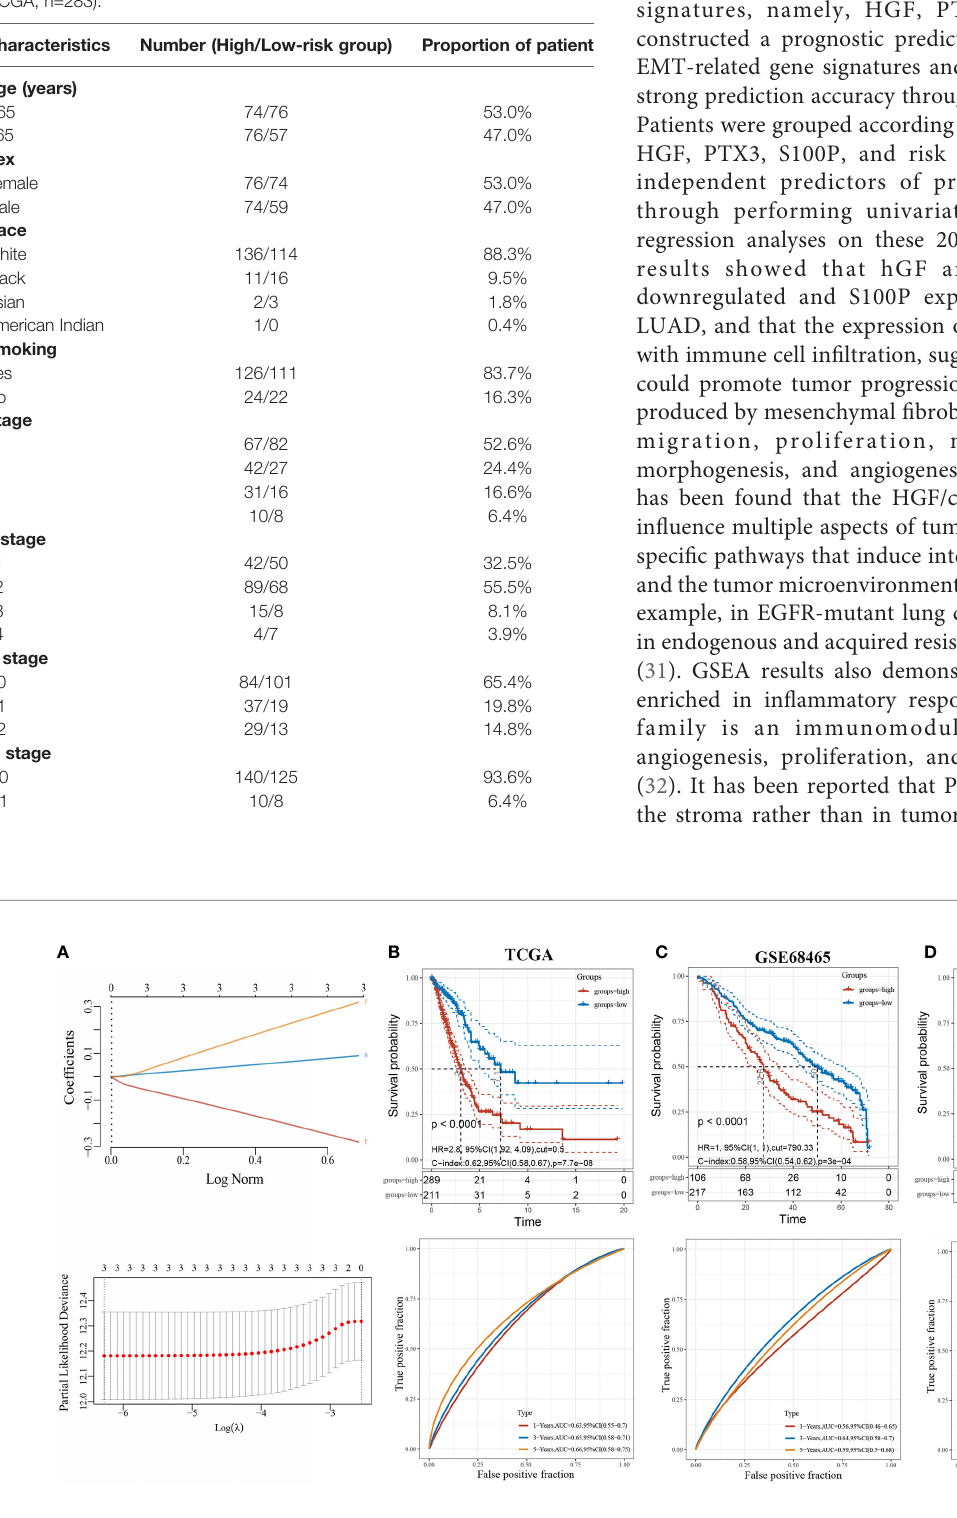
FIGURE 4 | Evaluation of three-gene risk model performance in independent datasets. (A) LASSO-Cox regression model based on three genes; (B) Kaplan-Meier curves, univariate Cox regression of overall survival, and ROC curve analyses in TCGA; (C) Kaplan-Meier curves, univariate Cox regression of overall survival, and ROC curve analyses in GSE68465; (D) Kaplan-Meier curves, univariate Cox regression of overall survival, and ROC curve analyses in GSE68571.